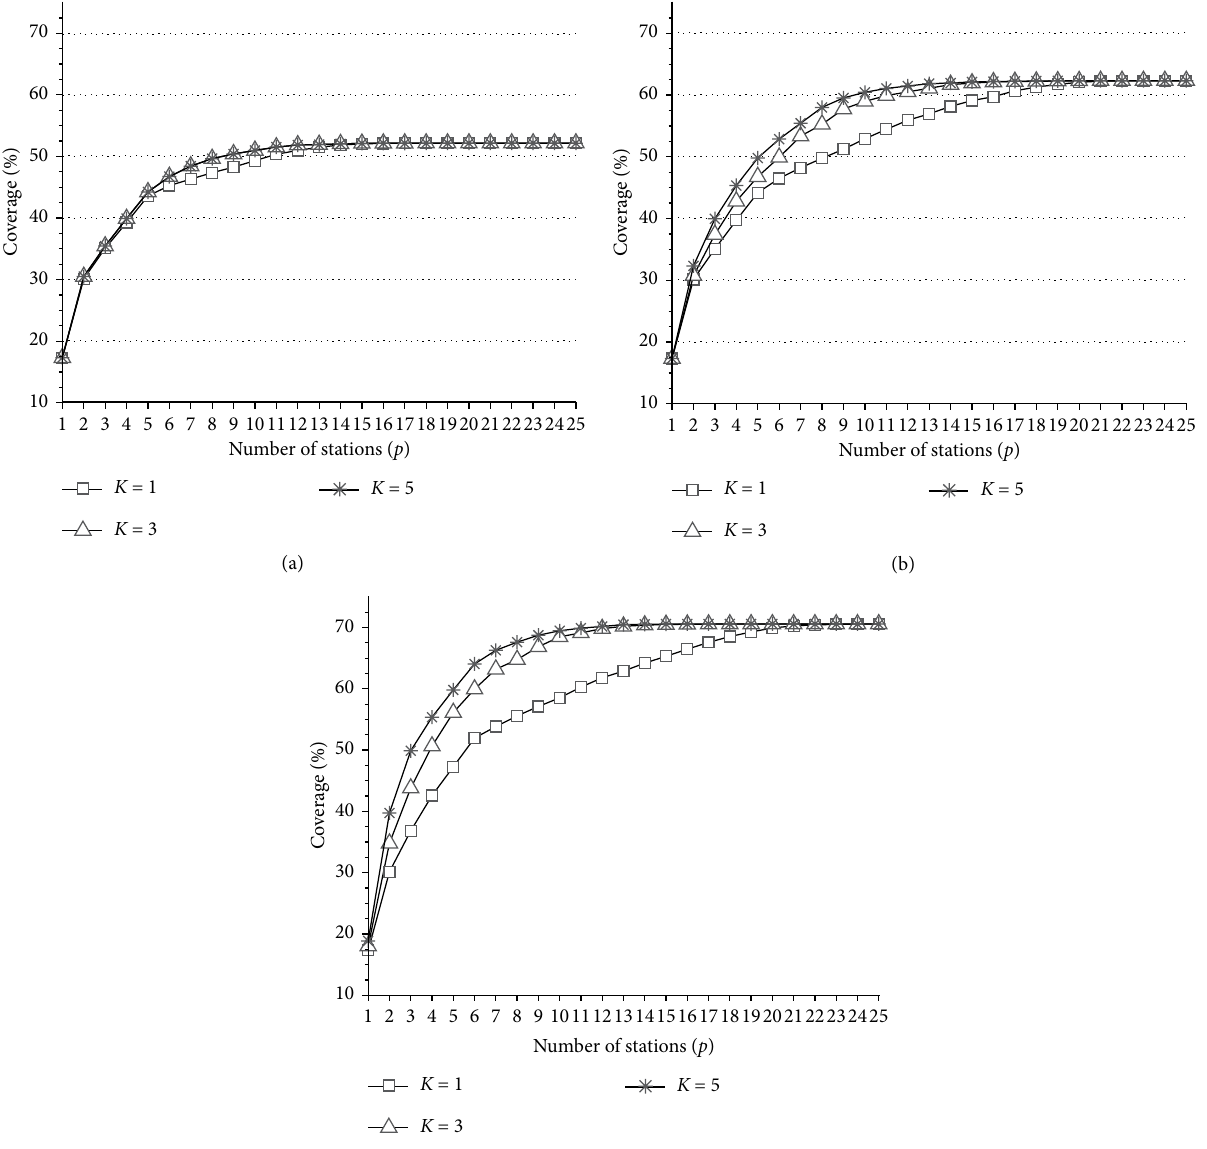
% . (b) % . (c) % 훽 = 0 훽 = 50 훽 = 100